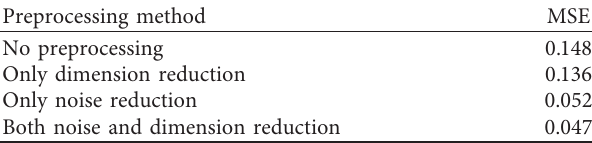
Table 5: Precisions of different preprocessing